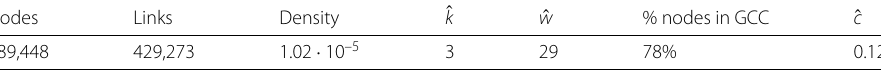
Table 1 Summary of the properties of the interaction graph G . The first three columns report the number of nodes, the number of links and the density of the graph, respectively. ˆ k and ˆ w indicate the average degree and the average strength. The last two columns report the percentage of nodes in the giant connected component and the average clustering coefficient ˆ c Nodes Links Density ˆ k ˆ w % nodes in GCC ˆ c 289,448 429,273 1.02 · 10 –5 3 29 78%